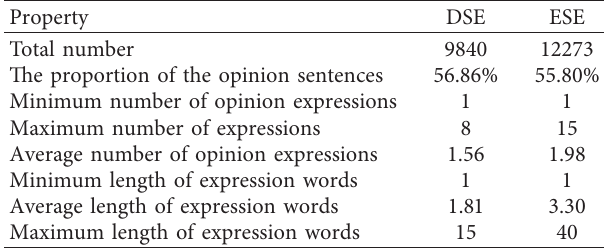
Table 2: MPQA corpus statistic